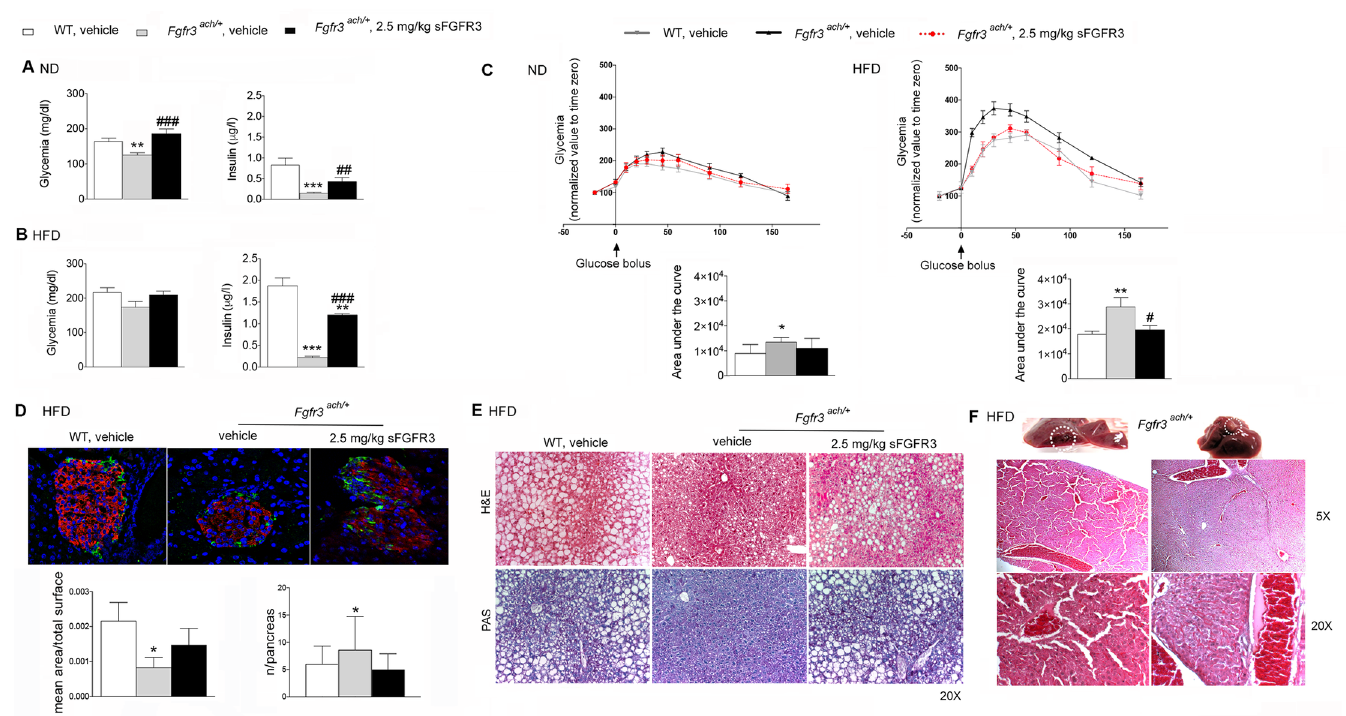
Fig 4. Glucose metabolism is altered in transgenic Fgfr3 ach/+ mice and restored with sFGFR3 treatment. Fasting glycemia and insulinemia of mice following 10 weeks of ( A ) ND or ( B ) HFD. ( C ) glucose tolerance test; glucose levels were normalized to the value of time -15 min and area under the curve corresponding to each group of mice. ( D ) Mice pancreas insulin content (immunohistochemistry of paraffin-embedded sections, red: insulin; green: glucose; blue: DAPI staining), mean of pancreas islets normalized to total surface and mean of islets number in each group under HFD condition. ( E ) Liver H&E and PAS staining under HFD condition. ( F ) H&E staining of hepatic nodules. Data are represented as mean ± SD (n = 8–10 mice to each group). Data followed normal distribution. (cid:3)(cid:3) p < 0.01, (cid:3)(cid:3)(cid:3) p < 0.001 versus vehicle-treated WT, # p < 0.05, ## p < 0.01 versus vehicle-treated Fgfr3 ach/+ ; Student’s t test.